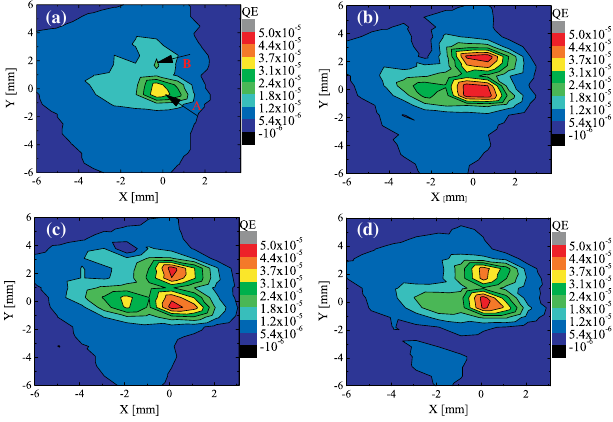
FIG. 4. QE map of Pb photocathode using 258 nm light before laser cleaning (a), and after laser cleaning with an energy density of 0 : 045 mJ = mm 2 (b), 0 : 087 mJ = mm 2 (c), and 0 : 09 mJ = mm 2 (d). Point (0,0) corresponds to the geometric center of the Pb